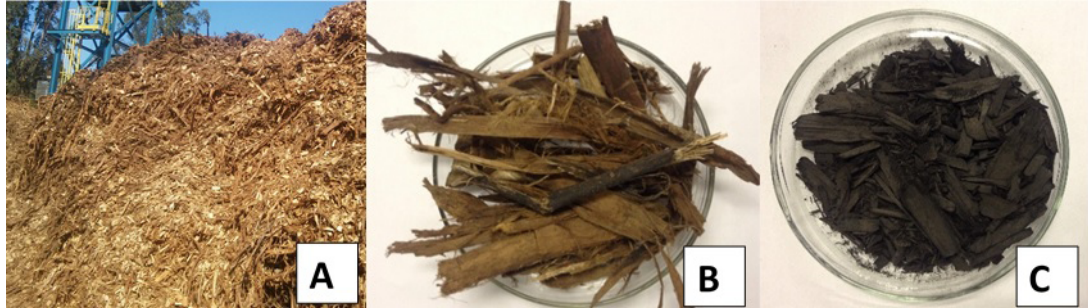
Figure 1. Investigated sample (A) eucalyptus bark (B) chopped bark (C) charcoal bark samples